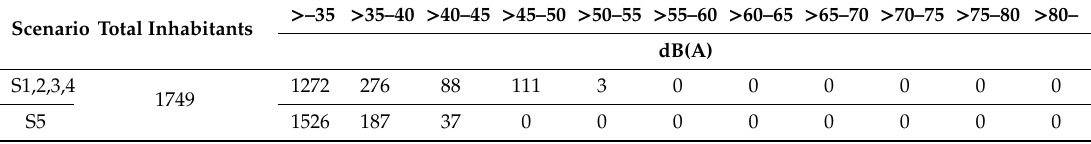
Table 2. Noise exposure of people in the night period.